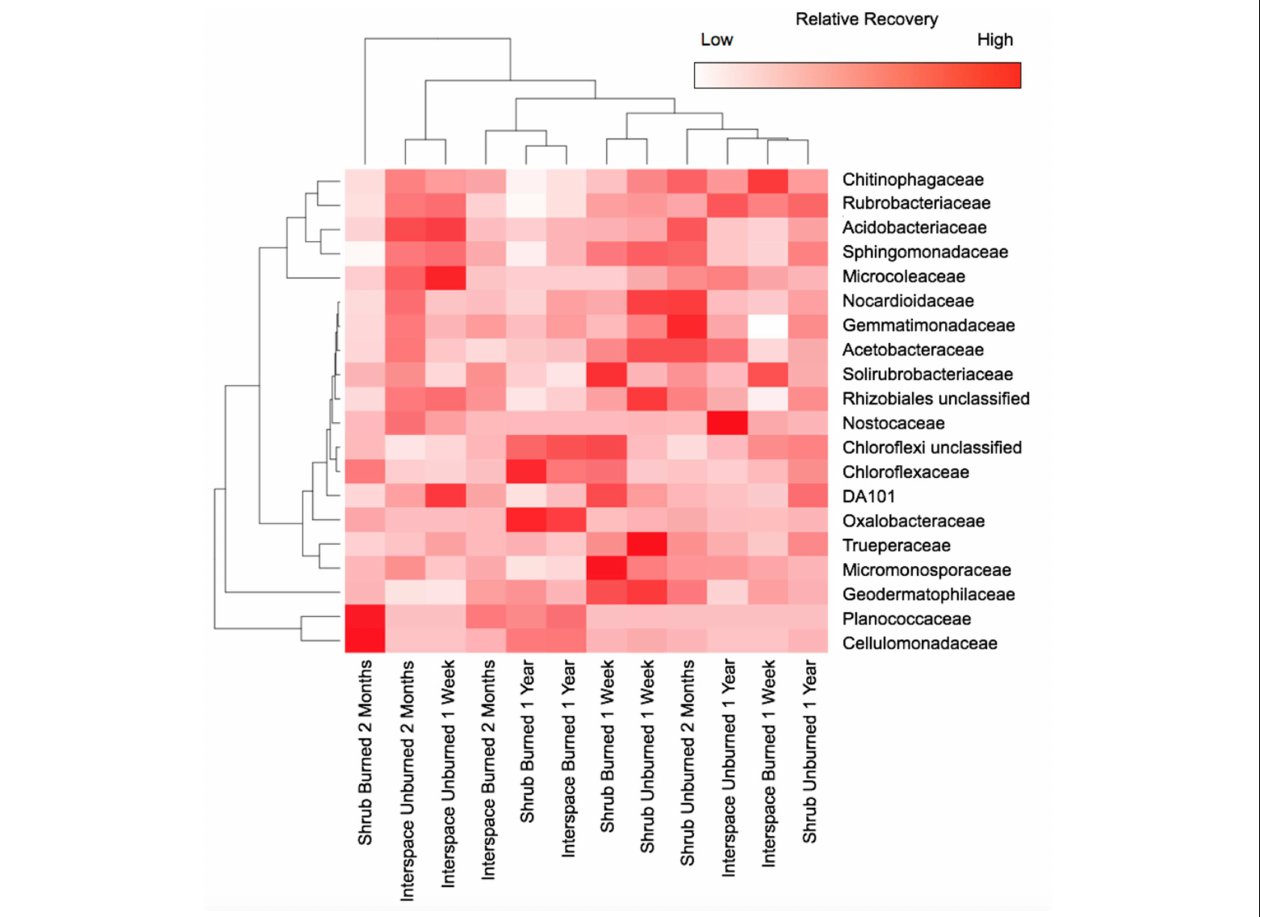
FIGURE 3 | Burning and time since fire selected for specific bacterial families based on heat map analysis and hierarchical clustering of the relative recovery of 20 bacterial families. Values are based on means with hierarchal clustering of the burned treatments, and shrub and interspace microsites (top) and families (left). Only families that contributed ≥ 1.0% to the total recovery of communities are presented with recovery based on 16S rRNA gene libraries. Values are means ( n =